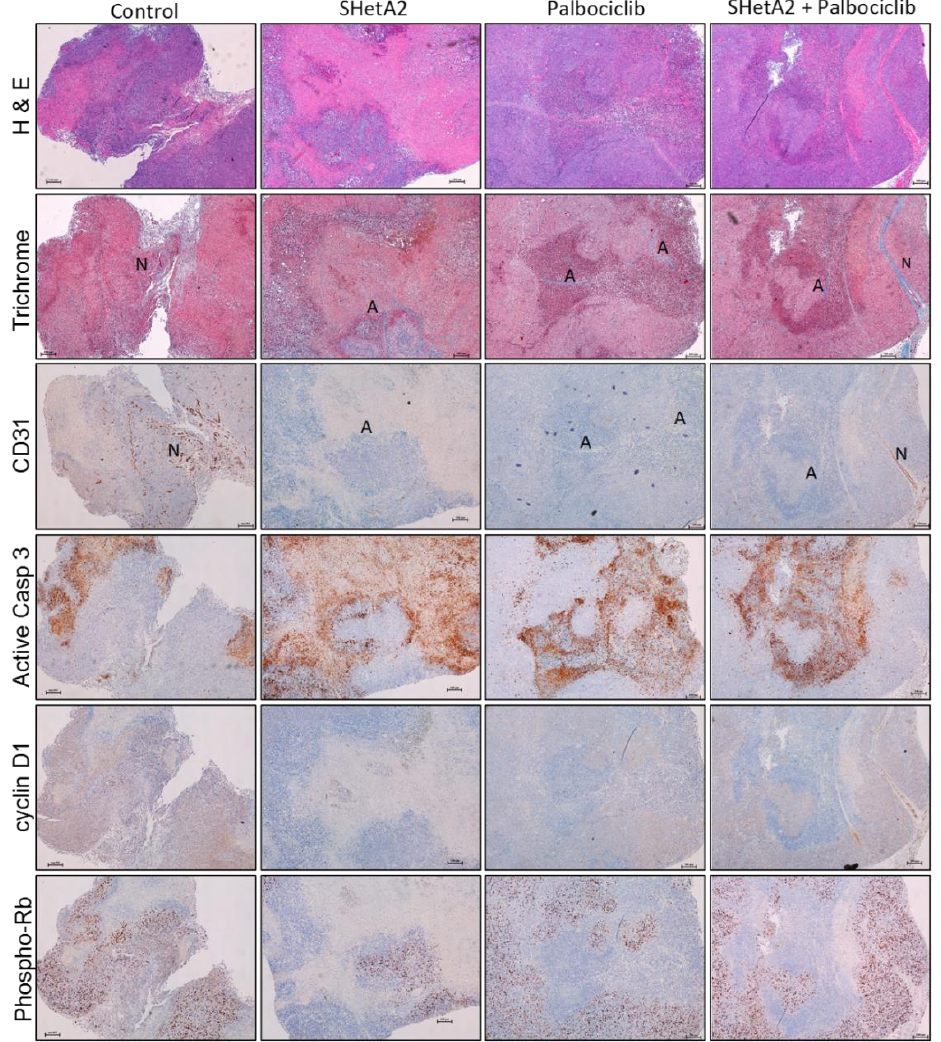
Figure 5. Effects of SHetA2 and palbociclib on SiHa xenograft tumor histology and target proteins. Representative sections of from the indicated treatment groups stained with H&E (Top row), trichrome stain (second row), CD31 (third row), cleaved caspase 3 (Active Casp 3), fourth row), cyclin D1 (fifth row), and phospho-Rb, sixth row). A = Abnormal dilated blood vessels, N = Normal blood vessel. The black line in each of the figures indicates 100 μ m.